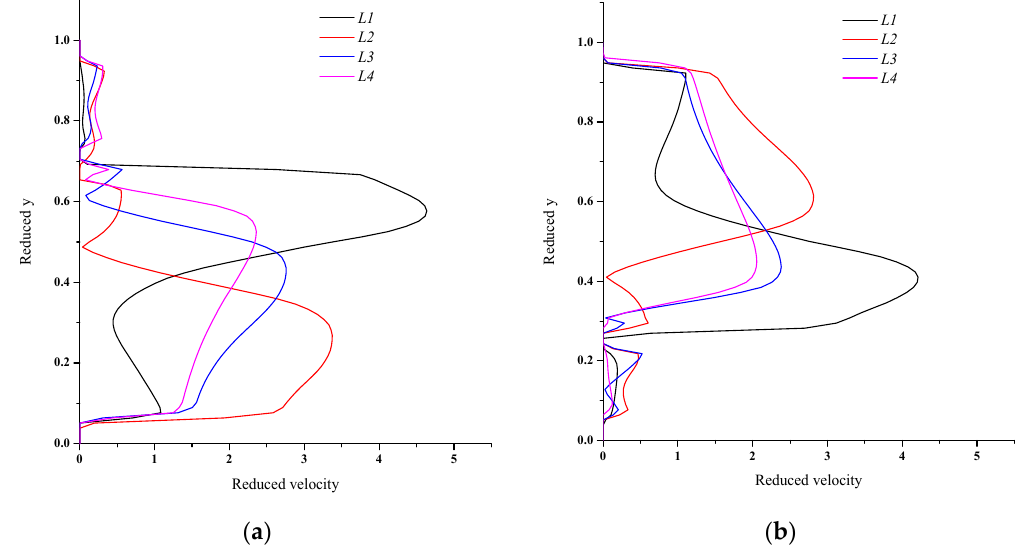
Figure 8. Reduced velocity versus reduced y at ( a ) line 1 and ( b ) line 2.